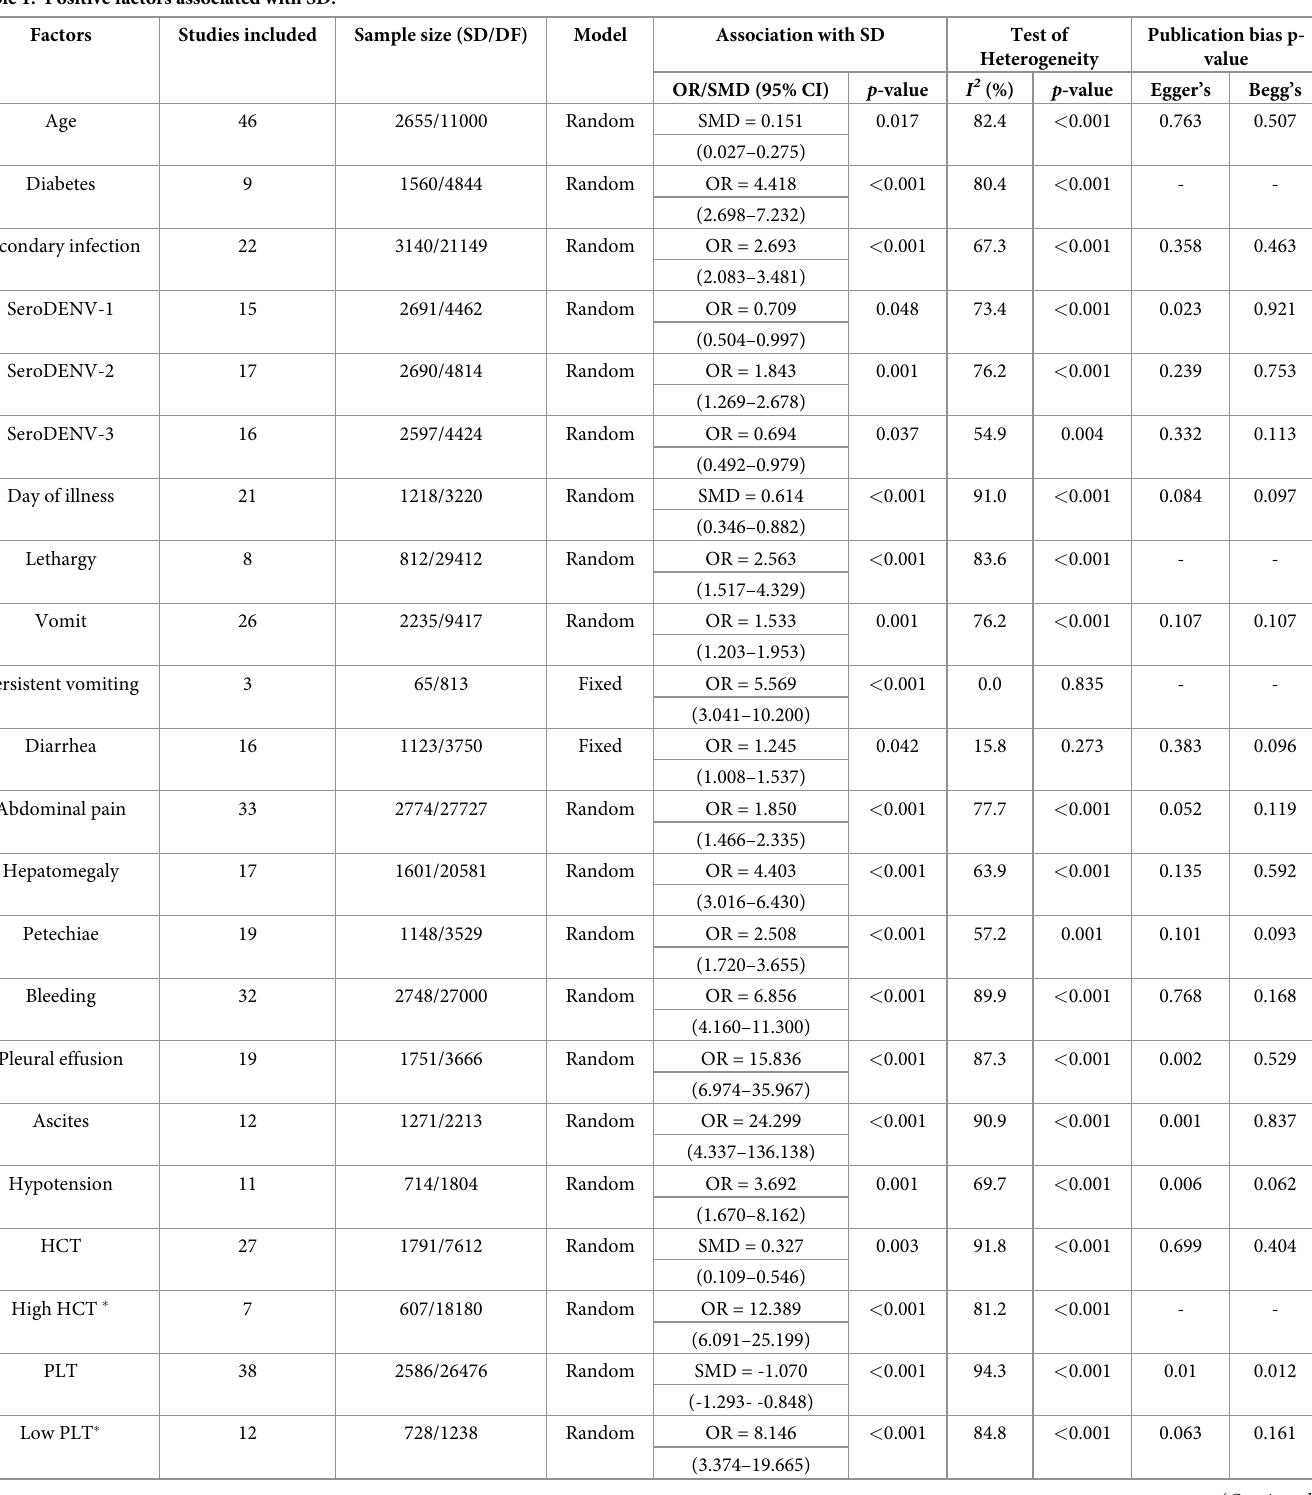
Table 1. Positive factors associated with